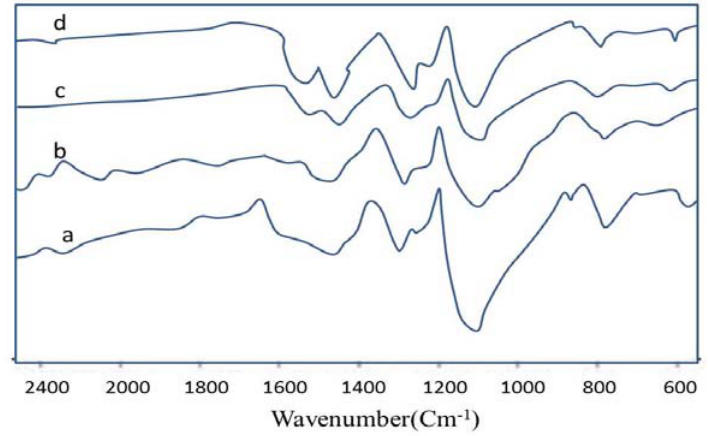
Figure 4. Fourier Transform Infrared Spectroscopy (FTIR) spectra of polyaniline nanofibers synthesized by interfacial polymerization at ( a ) 4.0; ( b ) 2.0; ( c ) 1.0; ( d ) 0.5 aniline/APS molar